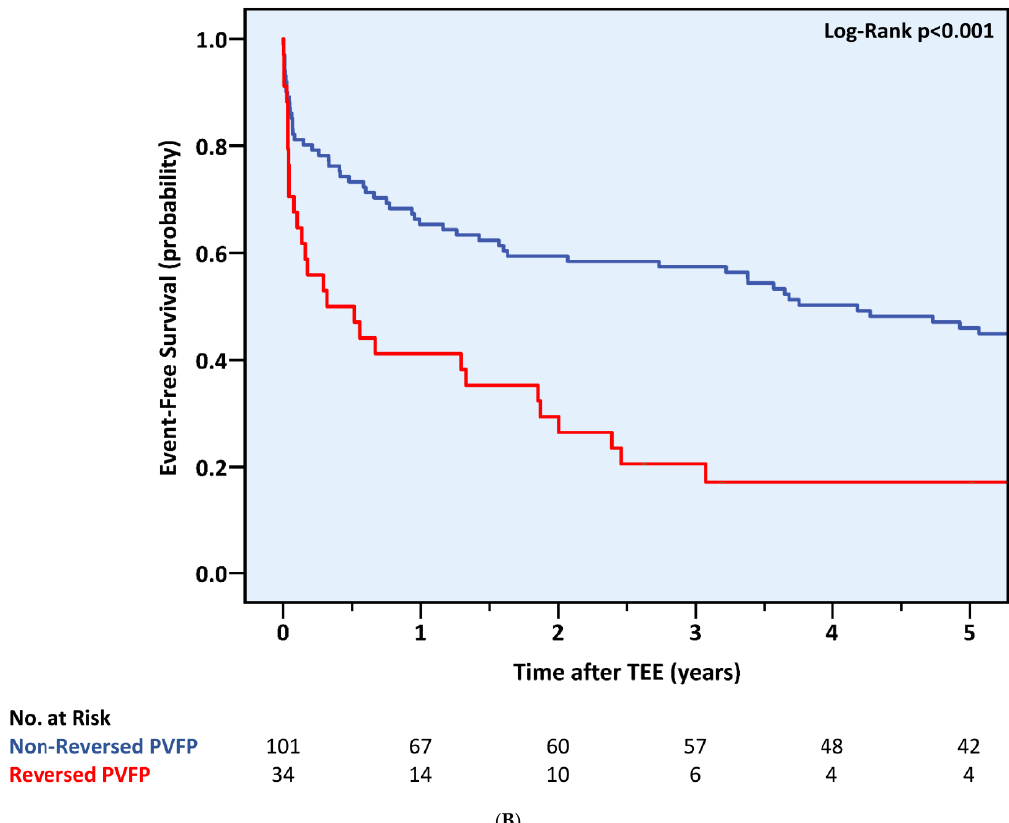
Figure 3. Five-Year Cumulative Incidence of the Combined Outcome of All-Cause Mortality, Mitral Intervention, or New-Onset Atrial Fibrillation According to Pulmonary Venous Flow Pattern at Baseline. PVFP = pulmonary venous flow pattern; TEE = transesophageal echocardiogram. ( A ) Normal vs. Reversed Pulmonary Venous Flow Pattern. ( B ) Non-Reversed vs. Reversed Pulmonary Venous Flow Pattern.